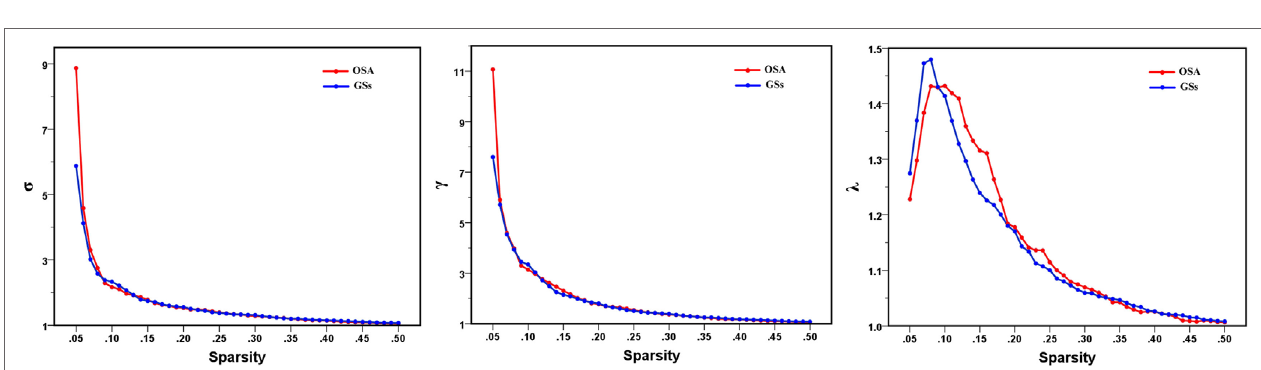
FigUre 3 | The relationship between abnormal functional connectivity (FC) and topological metrics of the default mode network (DMN) in patients with obstructive sleep apnea (OSA). The abnormal DMN FC value was significantly correlated with C p , L p , and E glob in patients with OSA. p < 0.05, which was considered statistically significant.